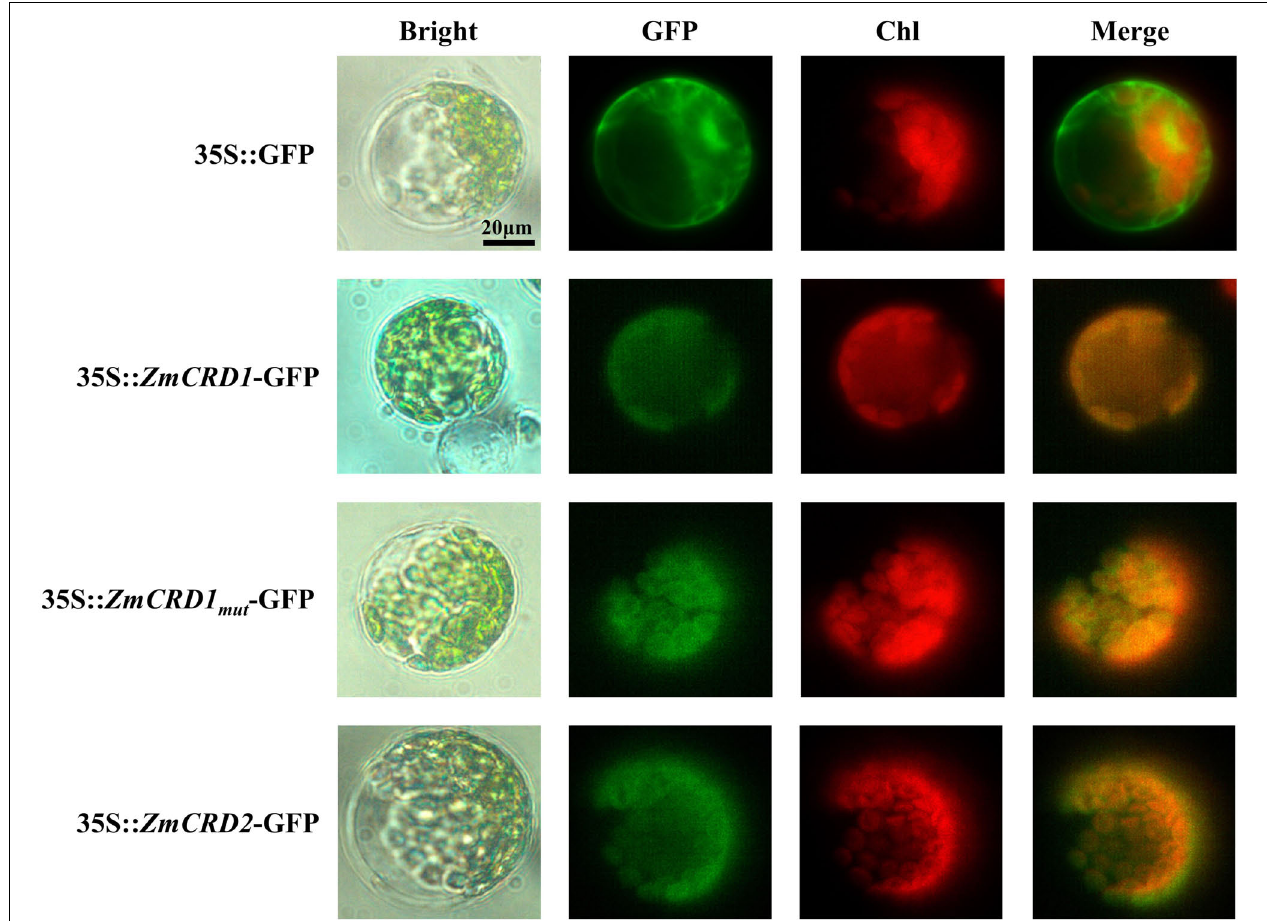
FIGURE 5 | Subcellular localization of ZmCRD proteins in protoplasts of Arabidopsis . The GFP-tag was fused to the C-terminus of ZmCRDs. ZmCRD1 mut refers to ZmCRD1 with p.A44T and p.T326M mutations derived from the pgl